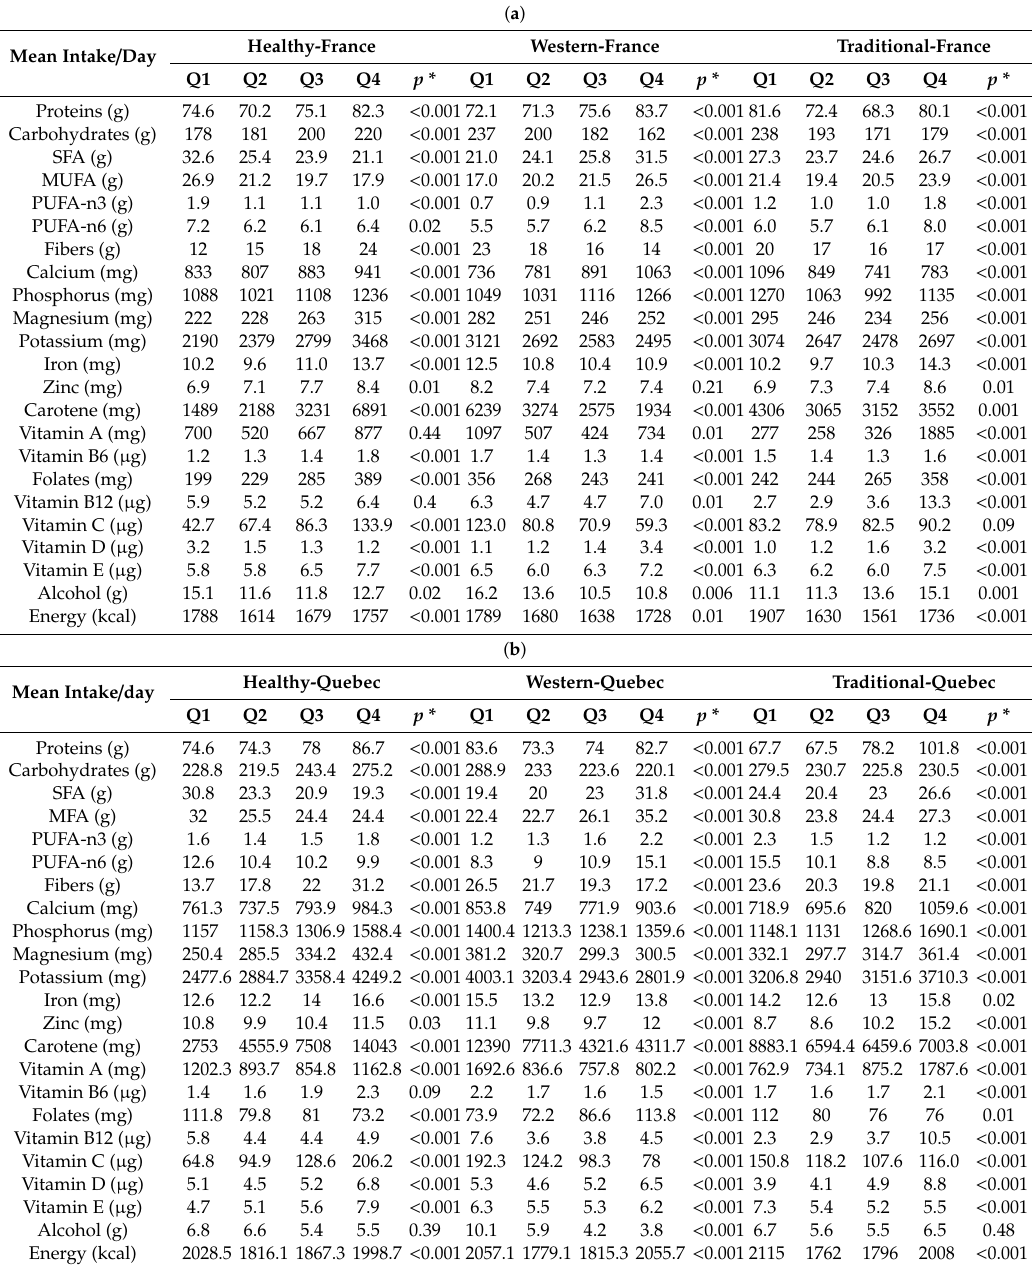
Table 2. Mean daily nutrient intake per quartile of component scores by nutrient patterns in ( a ) 3C ( n = 1388) and ( b ) NuAge ( n =